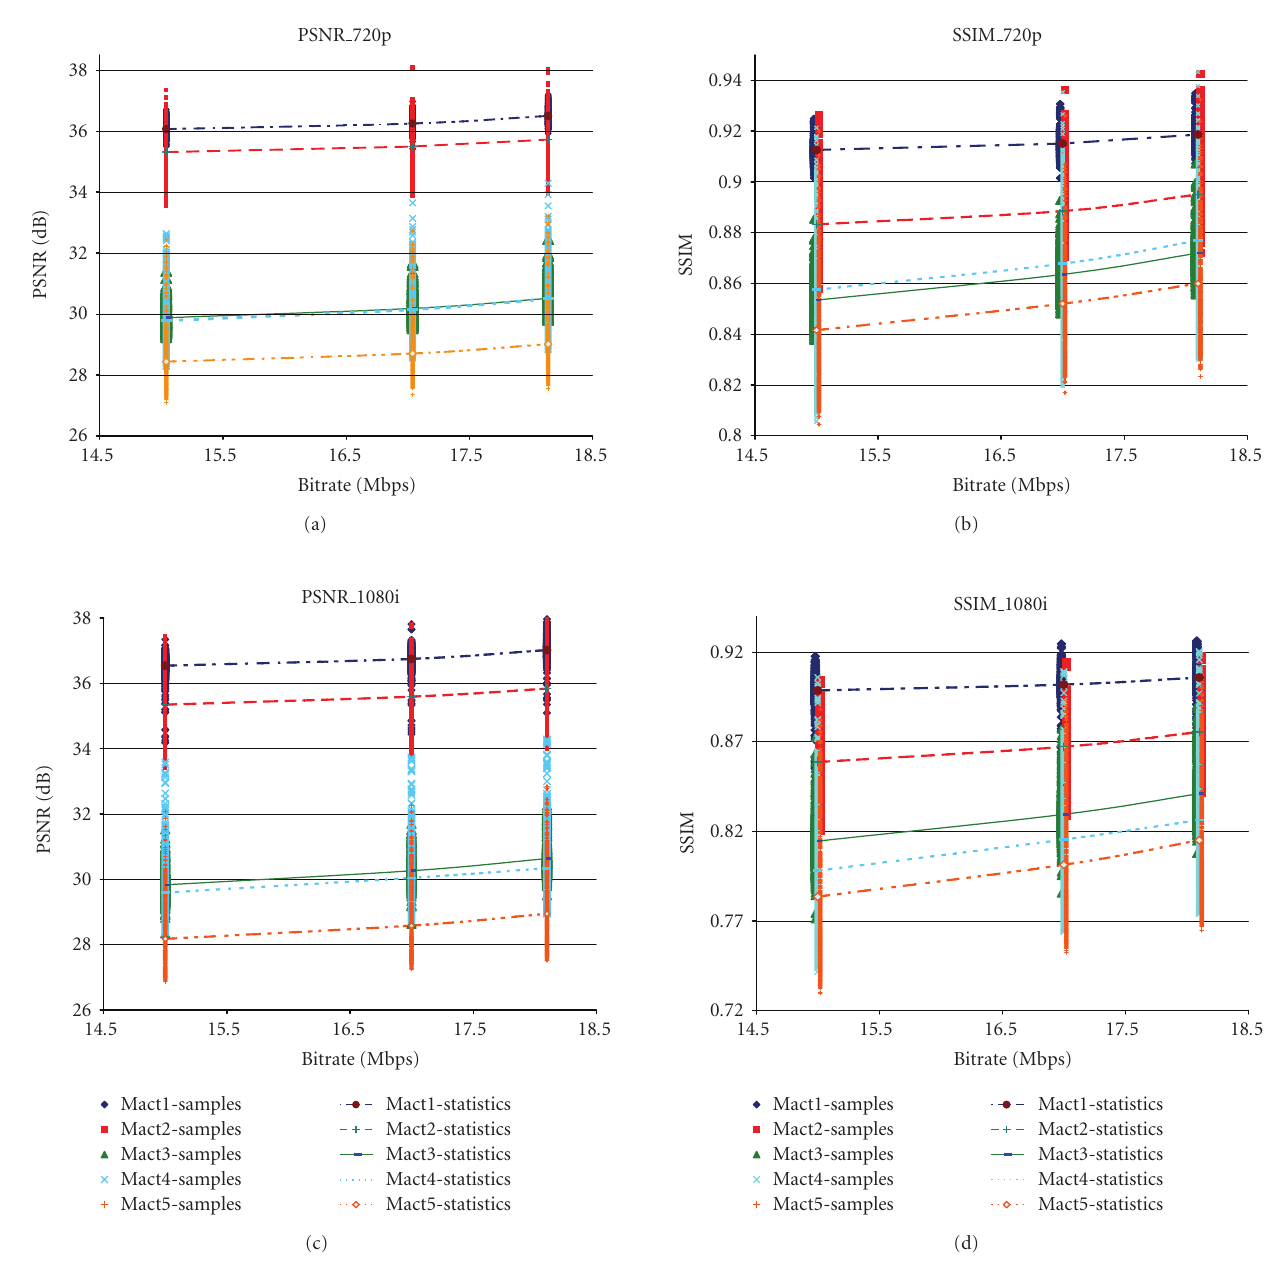
Figure 3: Graphs of the samples and mean curves of experimental data for the model Qm A .